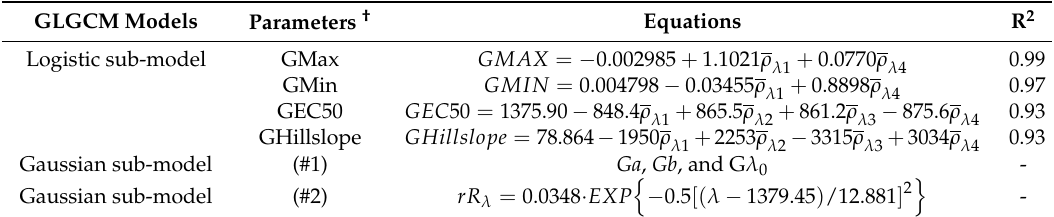
Table 4. Summary of the GLGCM model based on the in situ forest canopy spectra.